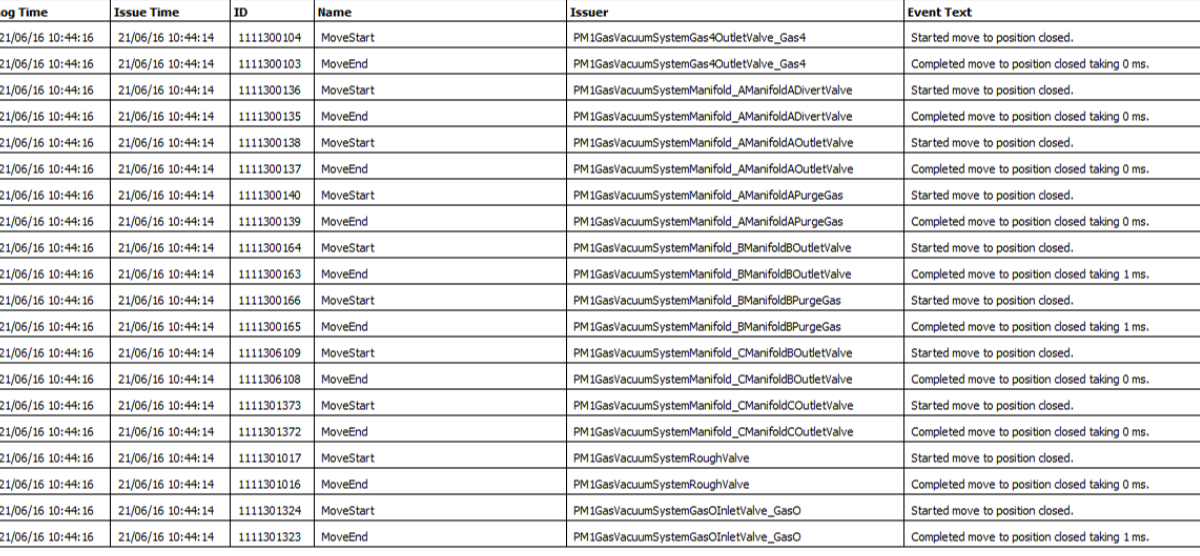
Figure 1. Example of an